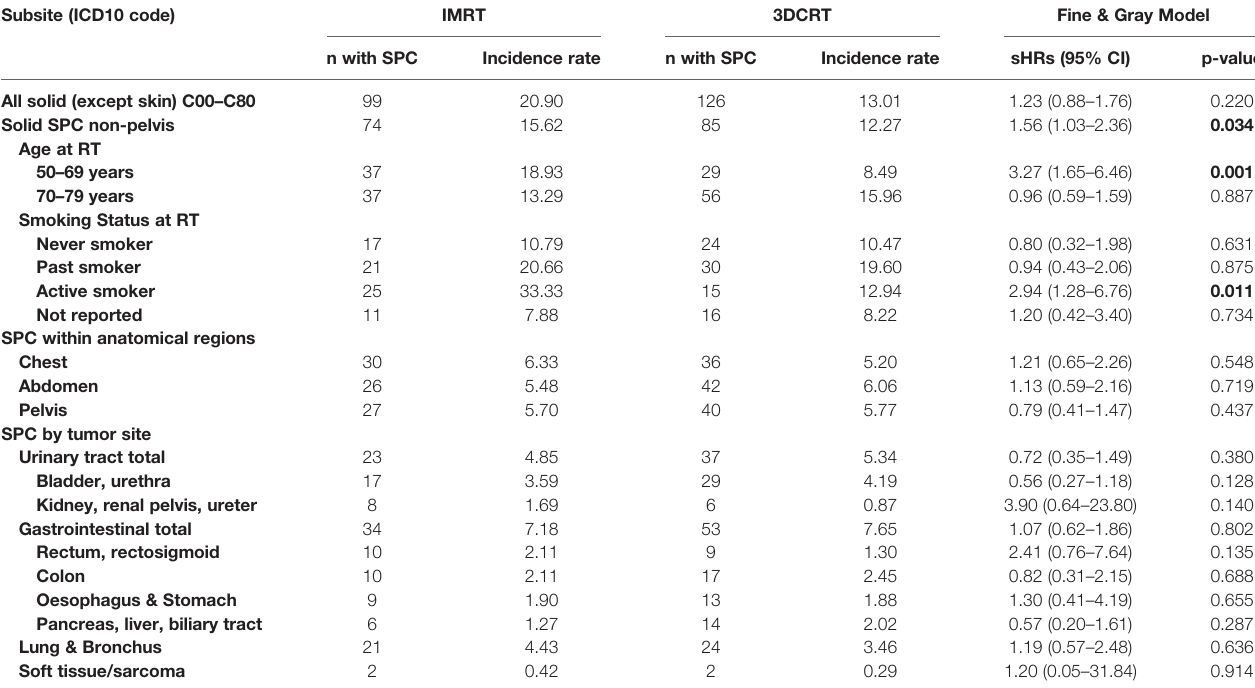
TABLE 4 | Crude incidence rates (per 10,000-person years) and estimated subHazard Ratios by Gray and Fine method (with adjustment for age and calendar year at time of radiotherapy) for IMRT versus the reference group 3DCRT. Subsite (ICD10